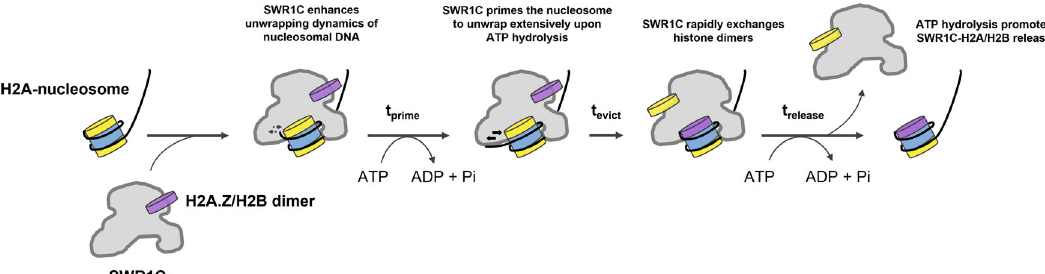
Fig. 7 | Kinetic model for H2A.Z deposition by SWR1C. Initially, SWR1C binds to thelinker-distalfaceofanasymmetricH2A-nucleosome,suchasthe+1nucleosome adjacenttotheNFR.SWR1CbindingatSHL2inducesstressandtransientdynamics at the nucleosomal DNA edge. While nucleosome-bound, SWR1C hydrolyzes ATP foranextendedperiodoftimetoprimethenucleosomalsubstrateforH2Aeviction ( t prime ), leading to more extensive unwrapping of nucleosomal DNA and transient